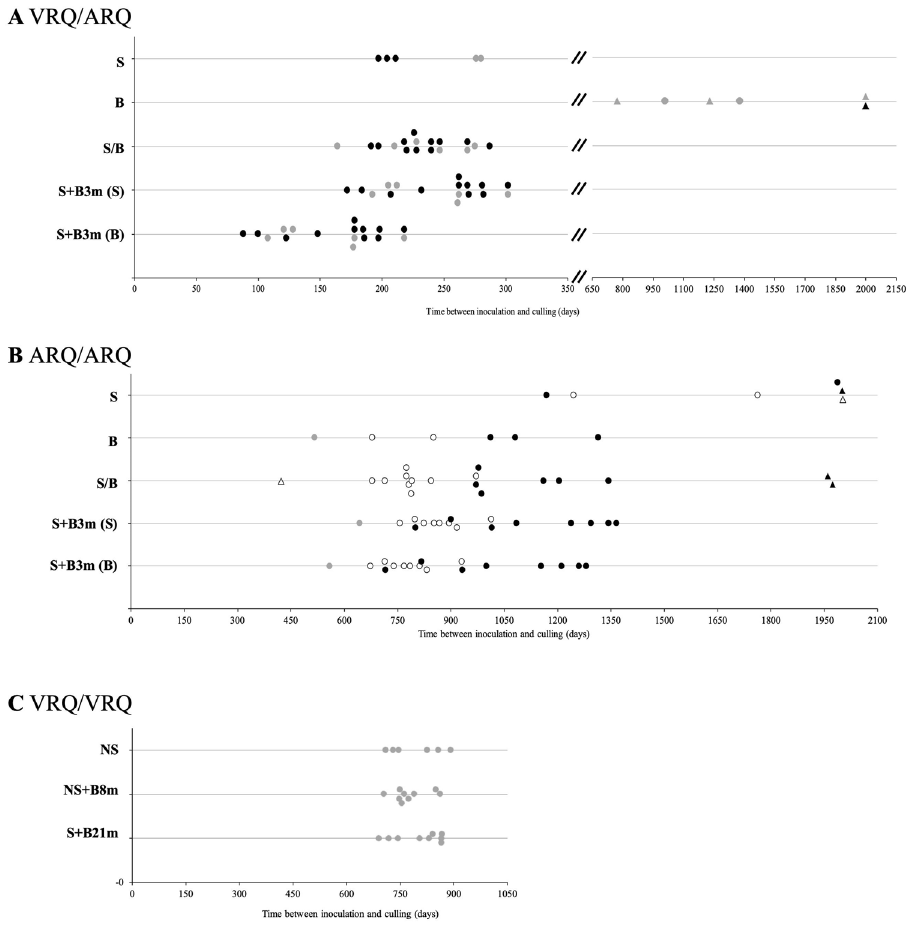
Figure 1. Incubation periods of individual VRQ/ARQ, ARQ/ARQ and VRQ/VRQ sheep. Sheep were inoculated with SSBP/1 scrapie, BSE or mixtures ( A , B ) or were infected with natural scrapie and then superinfected with BSE ( C ). The codon 141 PRNP genotype is indicated: LL 141 (grey fill); LF 141 (black fill); FF 141 (no fill). Circles are clinical and pathology positive sheep, triangles are non-TSE animals. In A and B , lines represent SSBP/1, BSE, S/B, S + B3m dating from SSBP/1 inoculation (S), and S + B3m dating from BSE inoculation ( B ). In C, lines represent natural scrapie (NS) and NS superinfected with BSE at 8 months of age (NS + B8m) or 21 months of age (NS + B21m). For natural scrapie incubation periods are calculated from birth (exposure to